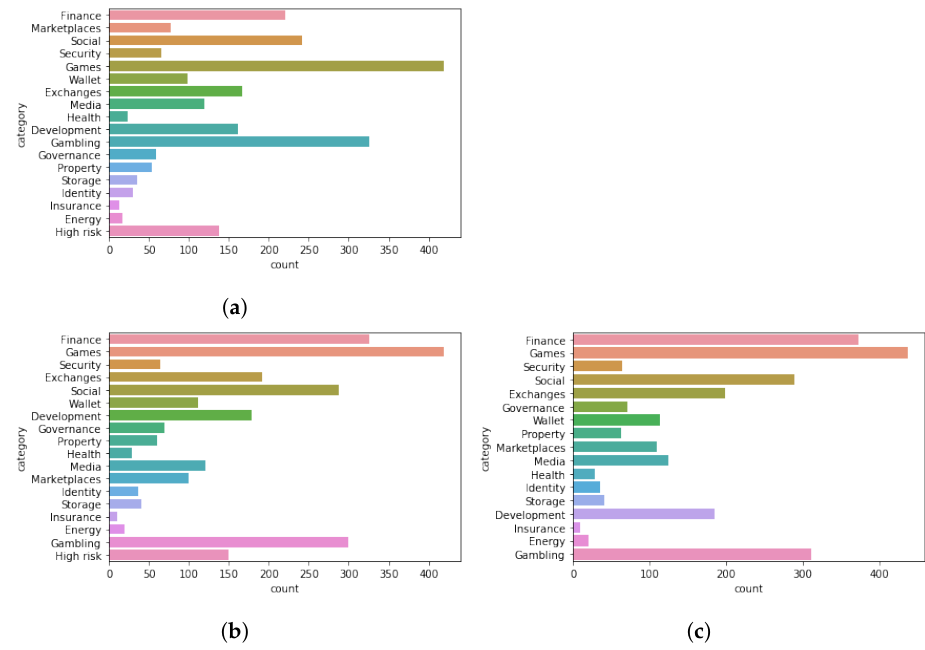
Figure 1. Status of DApps (information collected from the site www.stateofthedapp.com the 14th of May, 2021). ( a ) List of DApps (2019); ( b ) List of DApps (2020); ( c ) List of DApps (2021).